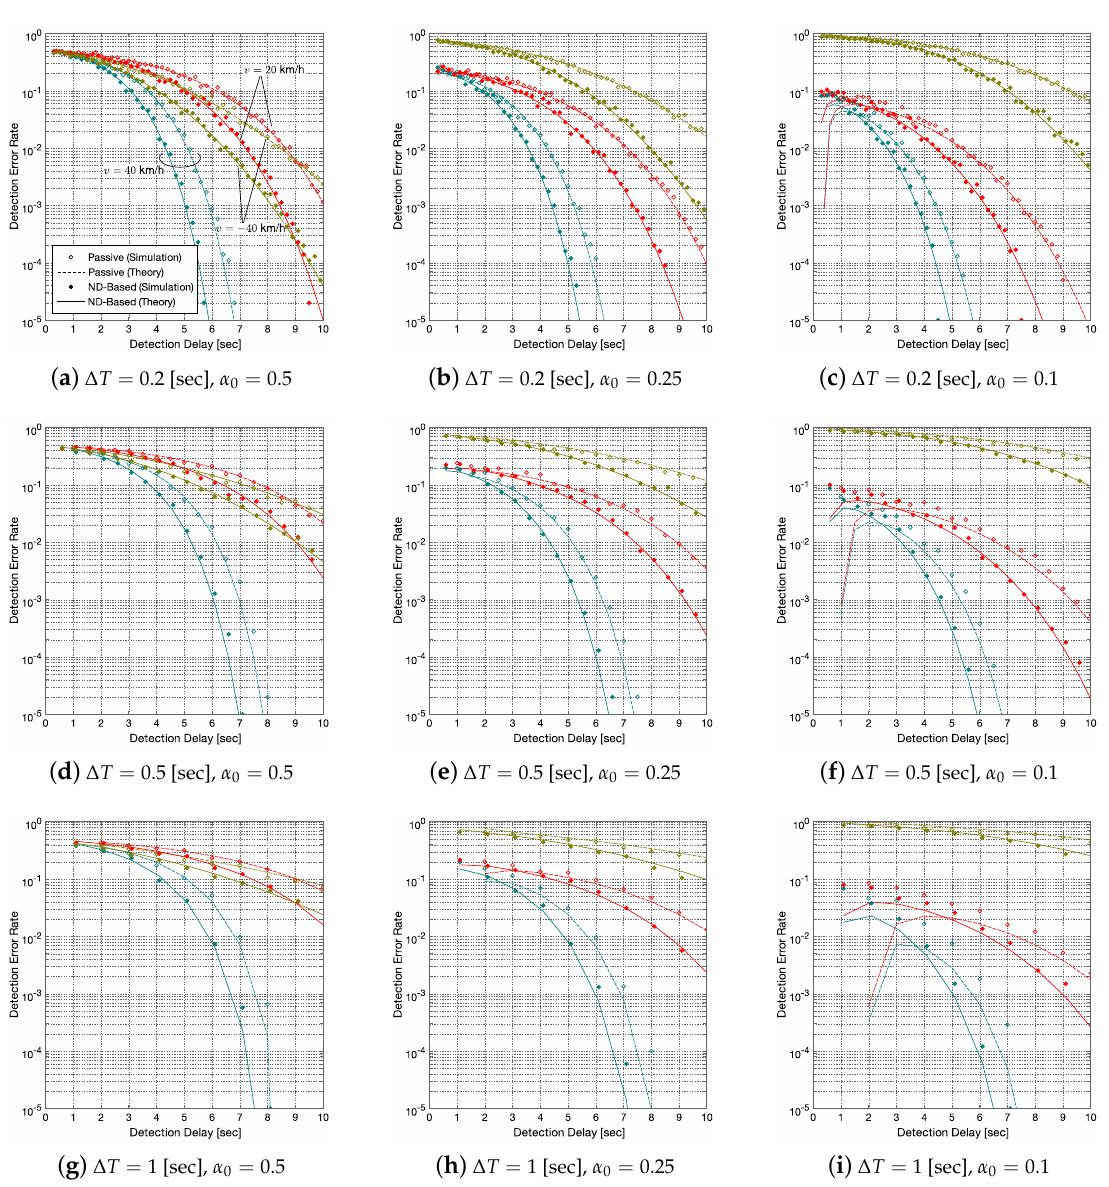
Figure 5. Detection delay vs. detection error rate. The detection error rates for v = 40 and 20 km/h show the probability of Type-I errors and those for v = − 40 km/h show the probability of Type-II